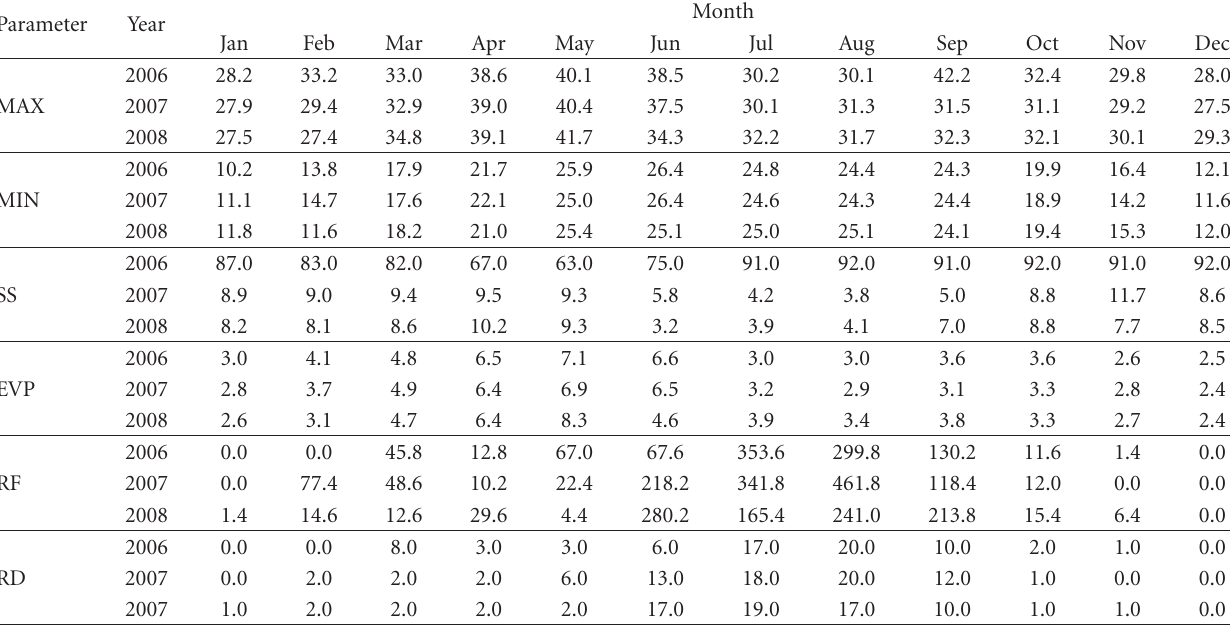
Table 1: Mean monthly weather data of Bilaspur, Chhattisgarh, India (Year 2006–2008). Parameter